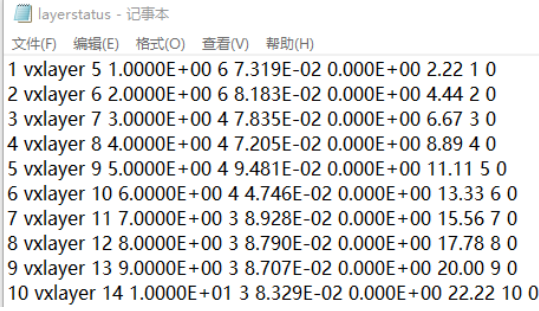
Fig. 10 Data after QT processing.